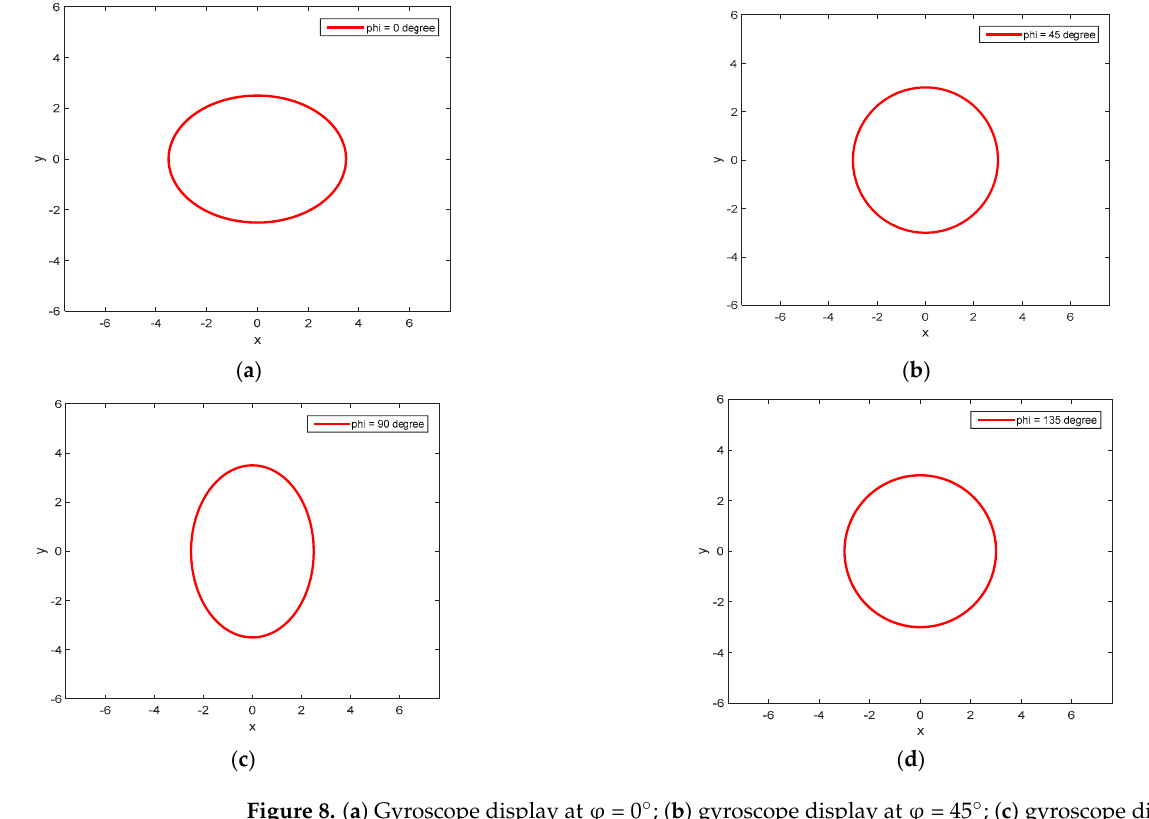
Figure 8. ( a ) Gyroscope display at φ = 0°; ( b ) gyroscope display at φ = 45°; ( c ) gyroscope display at φ = 90°; ( d ) gyroscope display at φ = 135°.